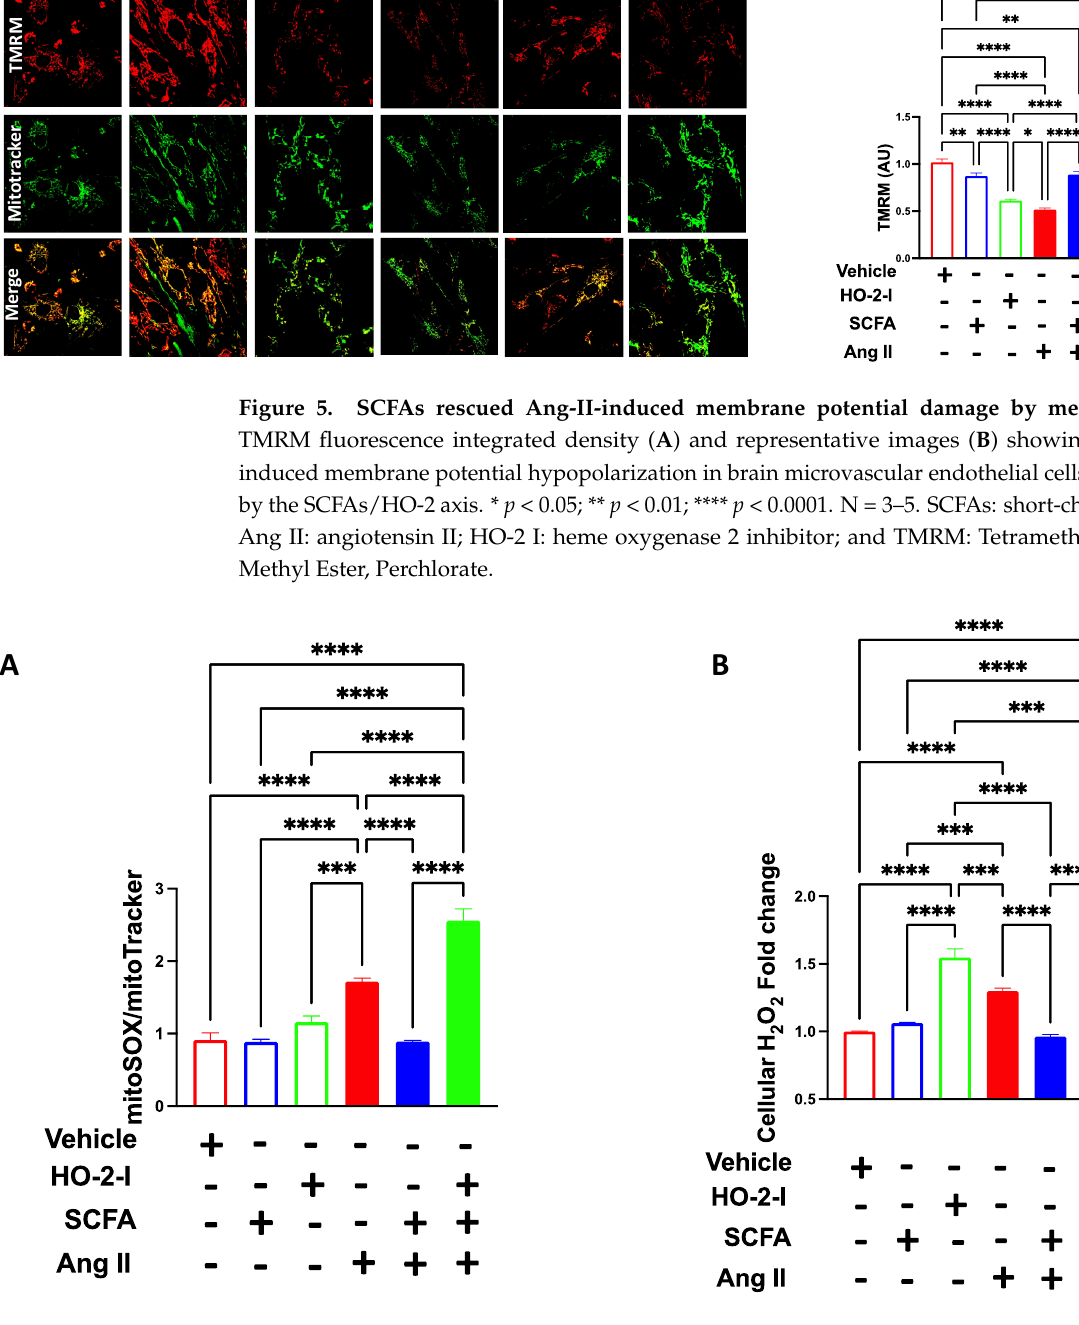
Figure 6. SCFAs rescued Ang-II-induced mitochondrial ROS and H 2 O 2 by mediating HO-2. MitoSOX fluorescence integrated density ( A ) and H 2 O 2 production ( B ) showing that Ang-II-induced increases in mitochondrial oxidative stress in brain microvascular endothelial cells were reversed by the SCFAs/HO-2 axis. *** p < 0.001; **** p < 0.0001. N = 3–5. SCFAs: short-chain fatty acids; Ang II: angiotensin II; HO-2 I: heme oxygenase 2 inhibitor; mitoSOX: dye for mitochondrial superoxide; and H 2 O 2 : hydrogen peroxide.